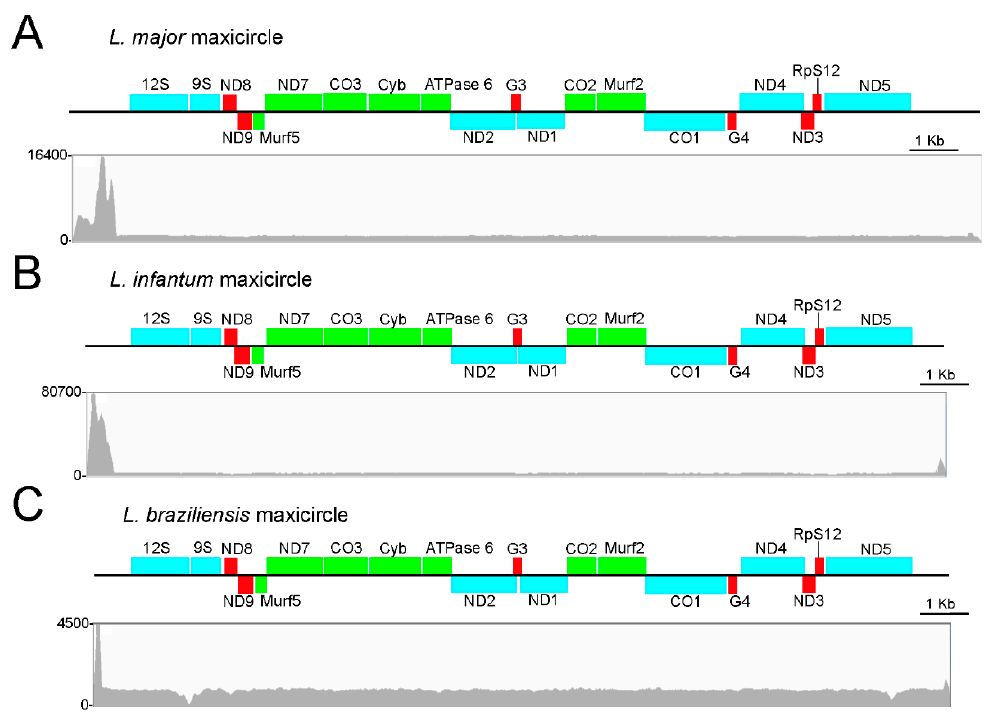
Figure 2. Diagram of the assembled contigs corresponding to the L. major ( A ), L. infantum ( B ) and L. braziliensis ( C ) maxicircles. The nomenclature and abbreviations of genes are those established for L. tarentolae [5]. Blue, green and red boxes are used to indicate non-edited genes, edited genes and pan-edited genes, respectively. The graph, below each gene map, shows the read depth, i.e., the number of reads aligned in a given position along the assembled contig sequence (linear scale).